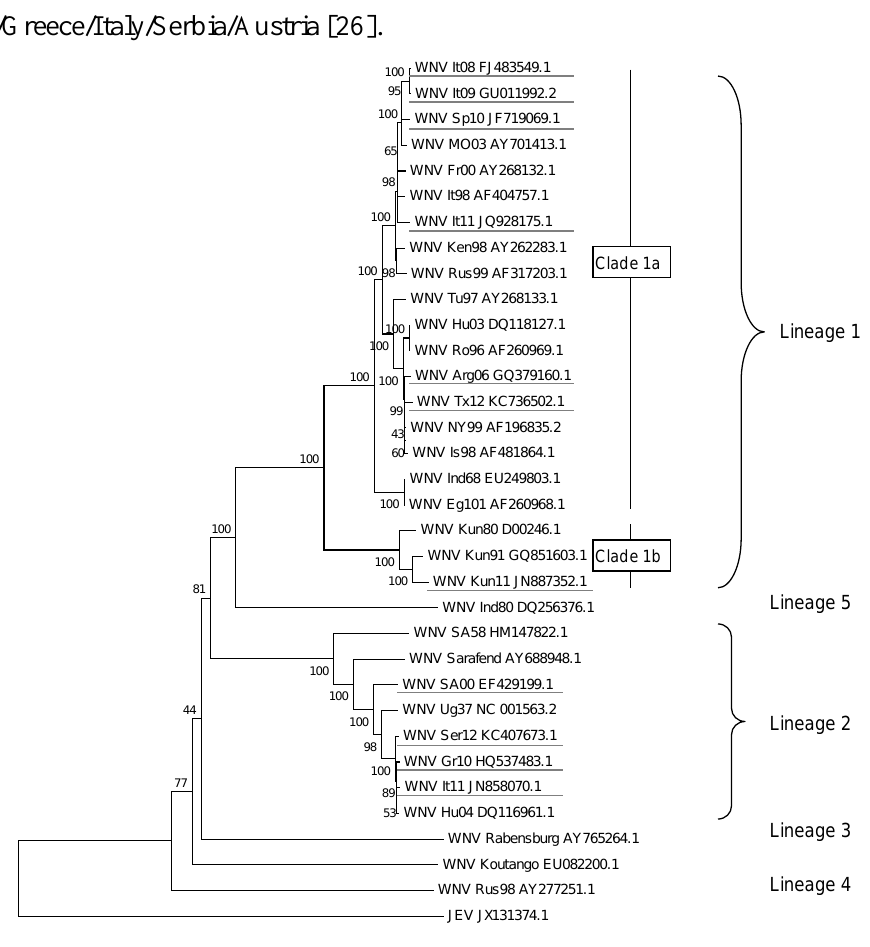
Figure 1. West Nile Virus (WNV) genetic diversity, evaluated using genetic alignment of complete genomic sequences. GenBank accession numbers are indicated on the tree branches of each virus; the first two or three letters stand for the country or the USA state reporting WNV (It = Italy, Sp = Spain, Mo = Morocco, Fr = France, Ken = Kenya, Rus = Russia, Tu = Tunisia, Hu = Hungary, Ro = Romania, Arg = Argentina, Tx = Texas, NY = New York, Is = Israel, Ind = India, Eg = Egypt, Kun = Kunjin Australia, SA = South Africa, Ug=Uganda, Ser = Serbia, and Gr = Greece) and the numbers indicate the year of isolation (96 = 1996, 10 = 2010). Japanese encephalitis virus (JEV), a closely related flavivirus, was used as an outgroup. The rooted phylogenetic tree was constructed using neighbor-joining with Jukes-Cantor parameter distances (scale bar) in MEGA (MEGA software, version 5.2 [25]). A bootstrapped confidence interval (1,000 replicates) and a confidence probability value based on the standard error test were also calculated using MEGA. The WNV strains responsible for recent human or equine outbreaks are underlined. The complete sequences of the most recent Romanian and Russian lineage 2 variants are not available, but at least two introduction events of lineage 2 strains have occurred in Europe: divergent lineage 2 strains have been observed in Romania/Russia